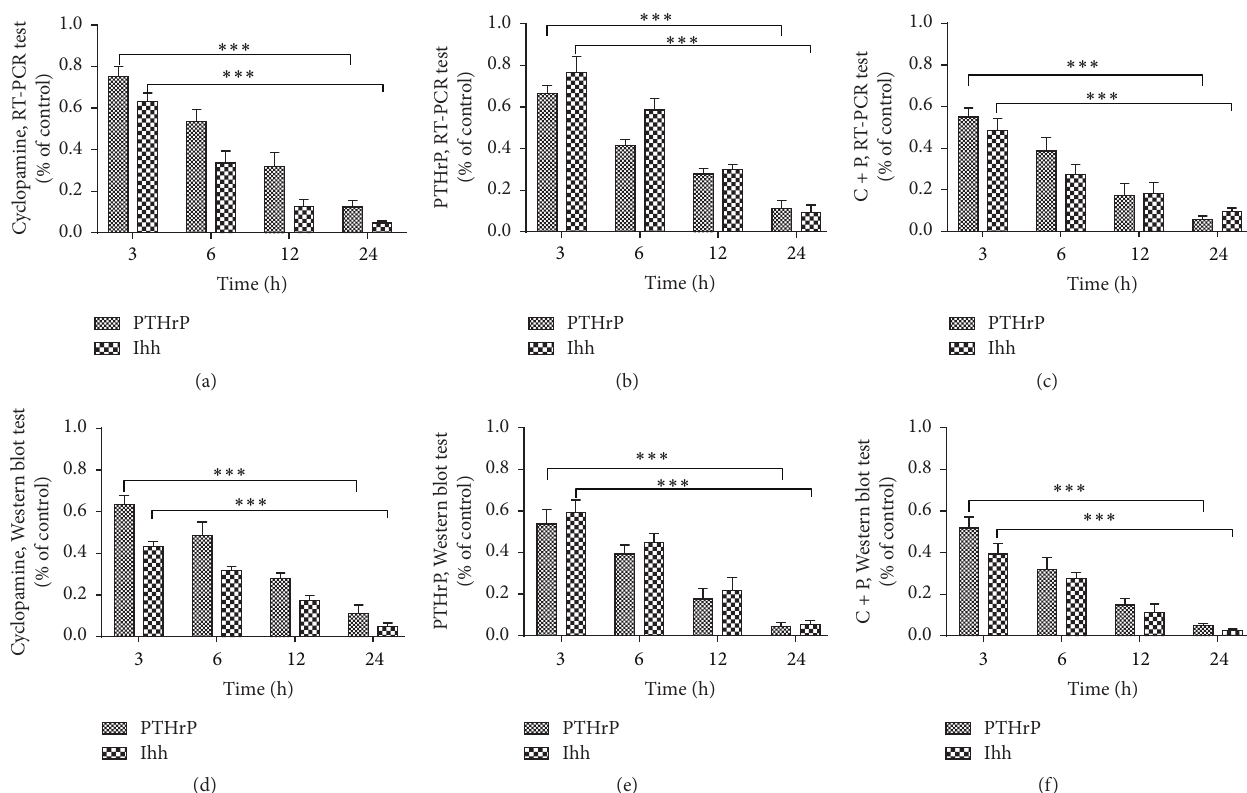
Figure 2: Ihh and PTHrP gene expression and protein synthesis under different intervention conditions. Note: (a), (b), and (c) RT-PCR results of Ihh and PTHrP gene expression levels by interventions with cyclopamine, PTHrP, and cyclopamine + PTHrP after 3, 6, 12, and 24 h. (d), (e), and (f) Western blot results of protein synthesis under the aforementioned conditions. All data were normalized to the control group ( 𝑛 = 3 , ∗∗∗ 𝑃 < 0.001 , NS: